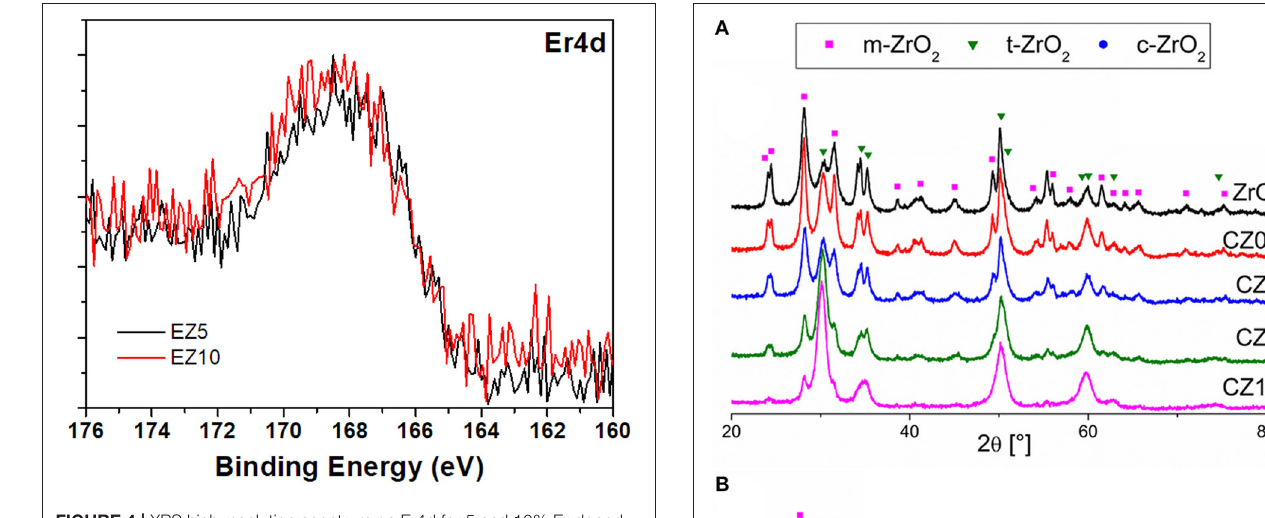
FIGURE 4 | XPS high resolution spectrum on Er4d for 5 and 10% Er-doped zirconia.